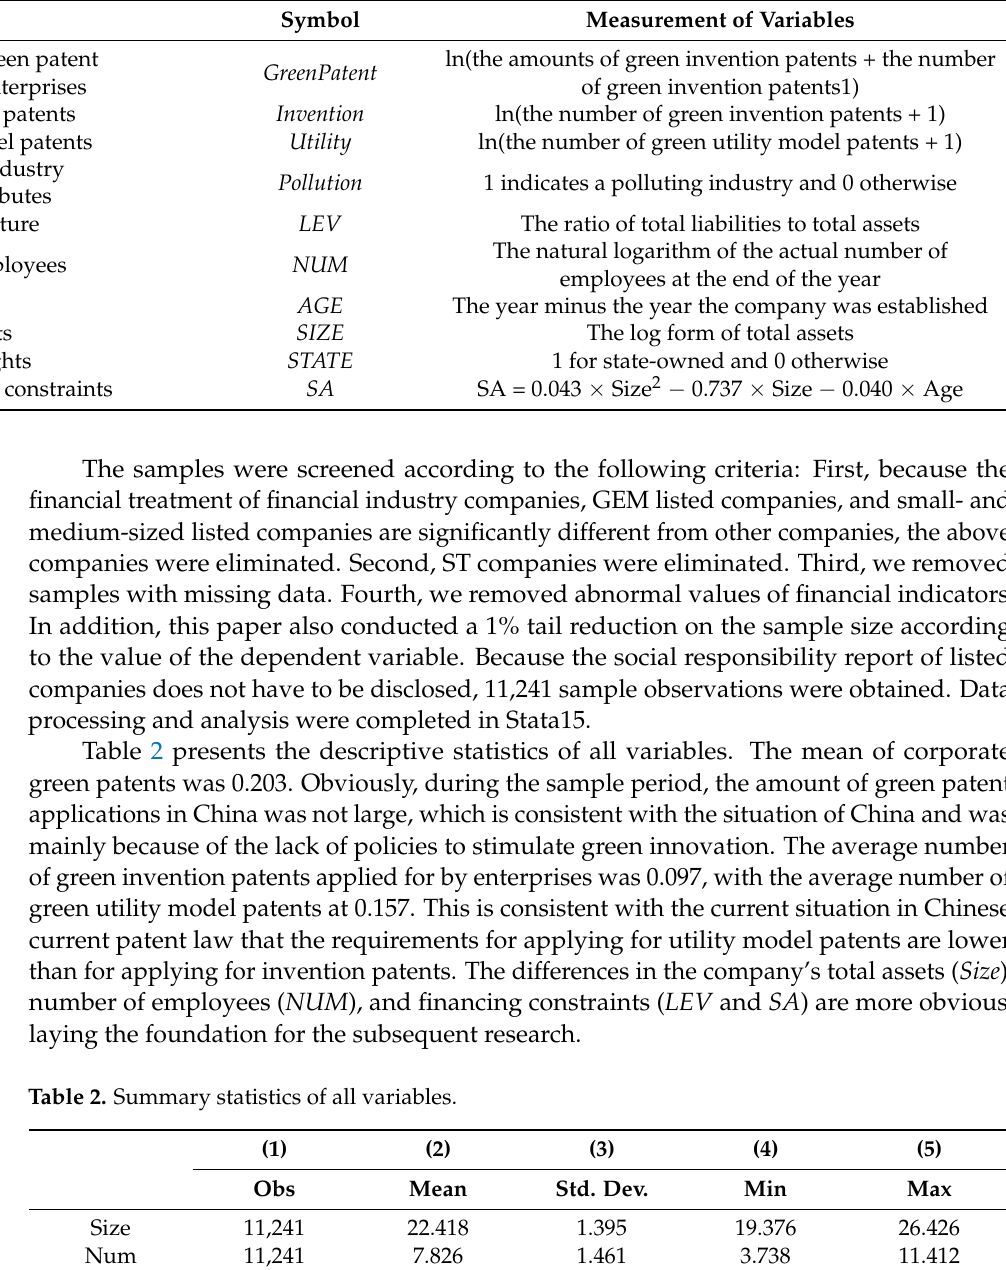
Table 1. Definitions of variables.